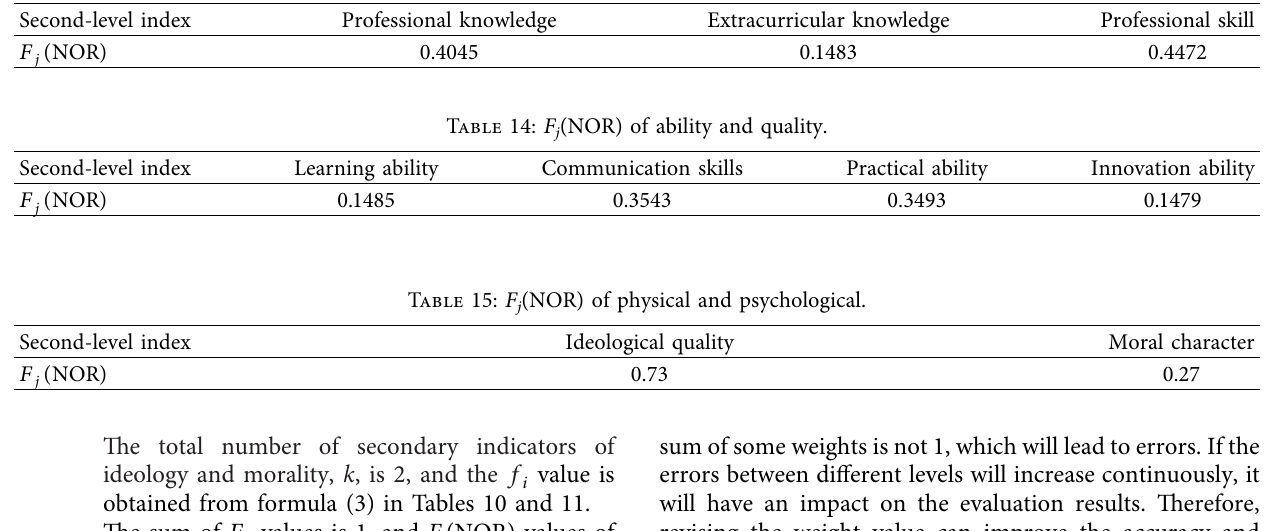
Table 13: F j (NOR) of knowledge level quality.